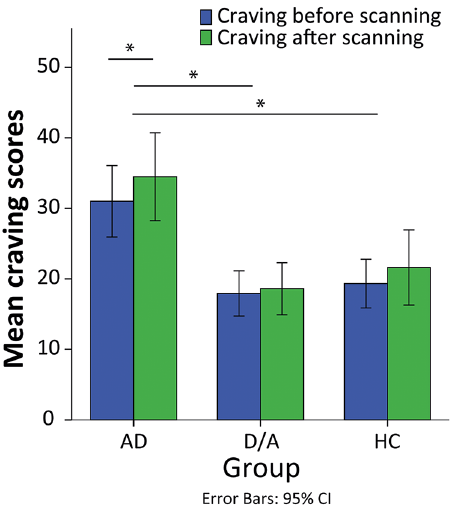
Figure 1. Mean craving scores before and after scanning in the three groups. The AD group showed higher craving scores compared to the D/A ( P =.001) and HC ( P =.003) groups. The difference between before and after was only significant for the AD group ( P =.004). Abbreviations: AD, alcohol dependents; CI, confidence interval; HC, healthy controls; D/A, psychopathology controls. pictures on positive valence for drinking on a scale from 0 (no valence) to 9 (very salient) immediately after scanning.